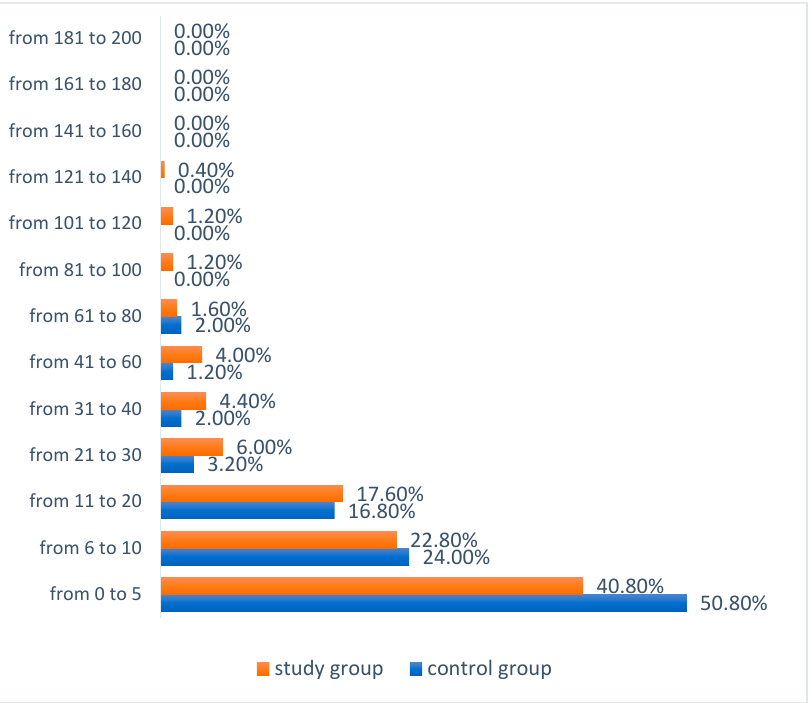
Figure 8. Number of app users marking a particular number of points in the tactile test—Test I.